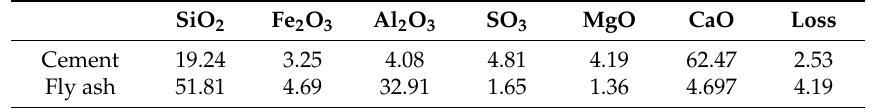
Table 2. Composition of cement and fly ash (%).